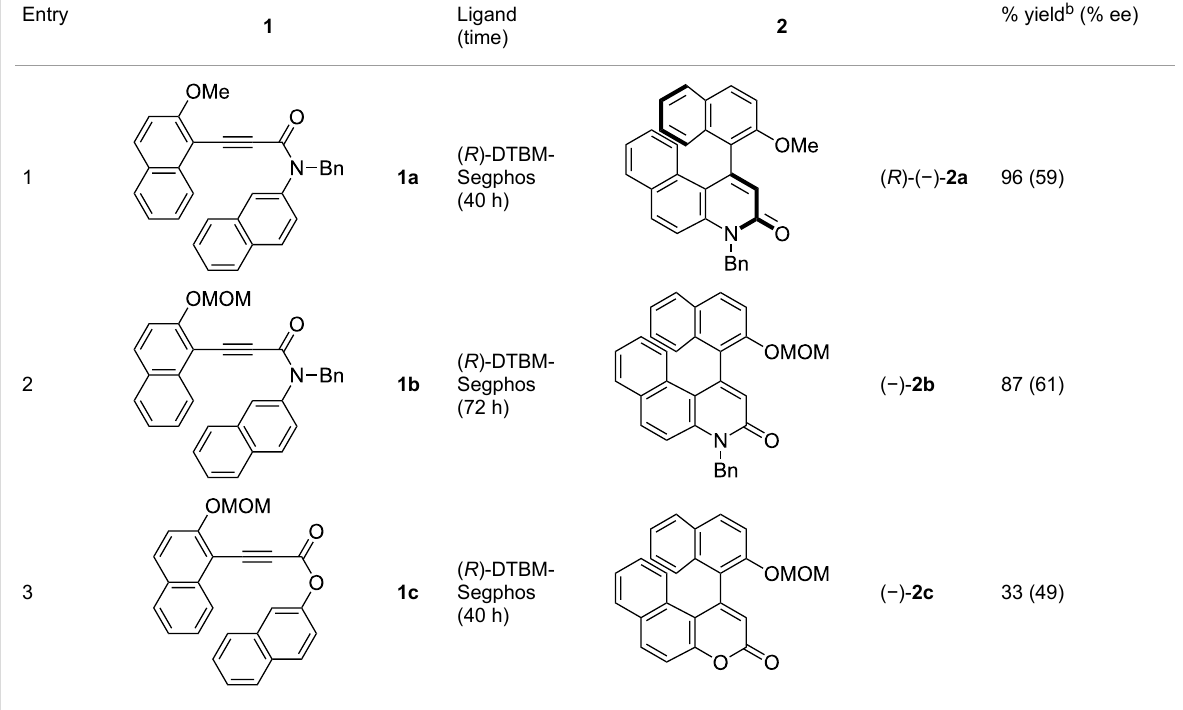
Table 2: Cationic gold(I)-complex catalyzed atropselective intramolecular hydroarylation of 1a – g leading to heterobiaryls 2a – g . a